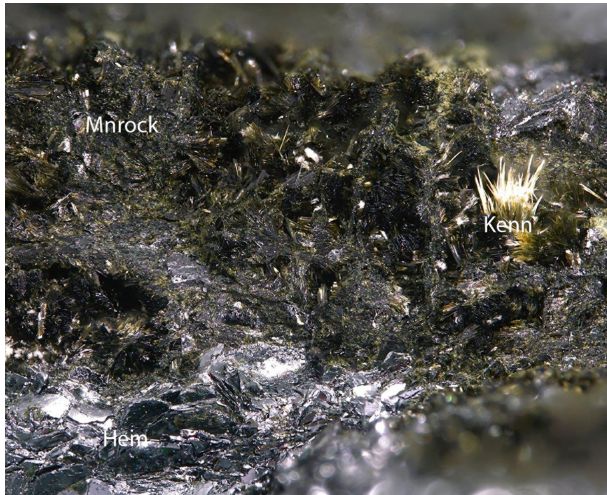
Figure 2. Manganrockbridgeite associated with hematite and ken- ngottite. Field of view: 6mm. Photo by Christian